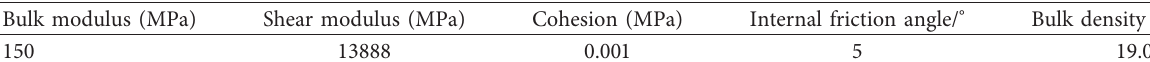
Table 4: Parameters of goaf.